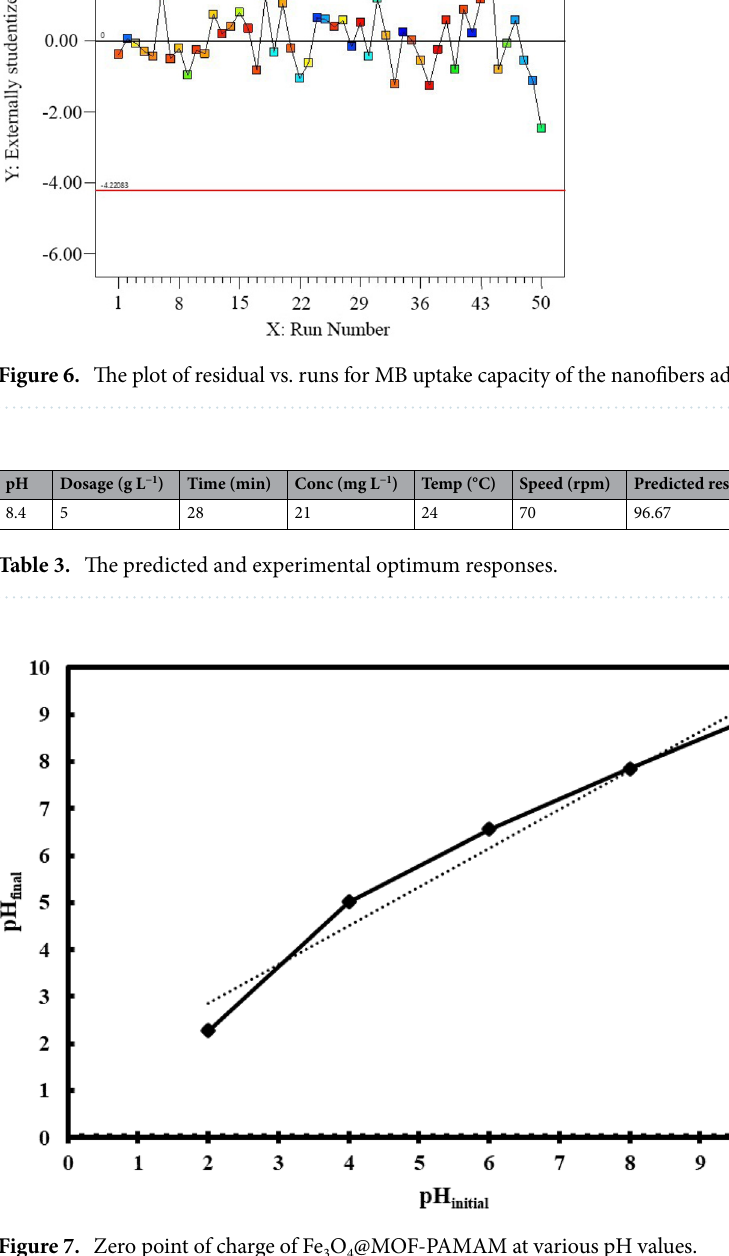
(cid:31) S (cid:31) H + . (cid:31) (cid:31) RT (cid:30) R (cid:30)